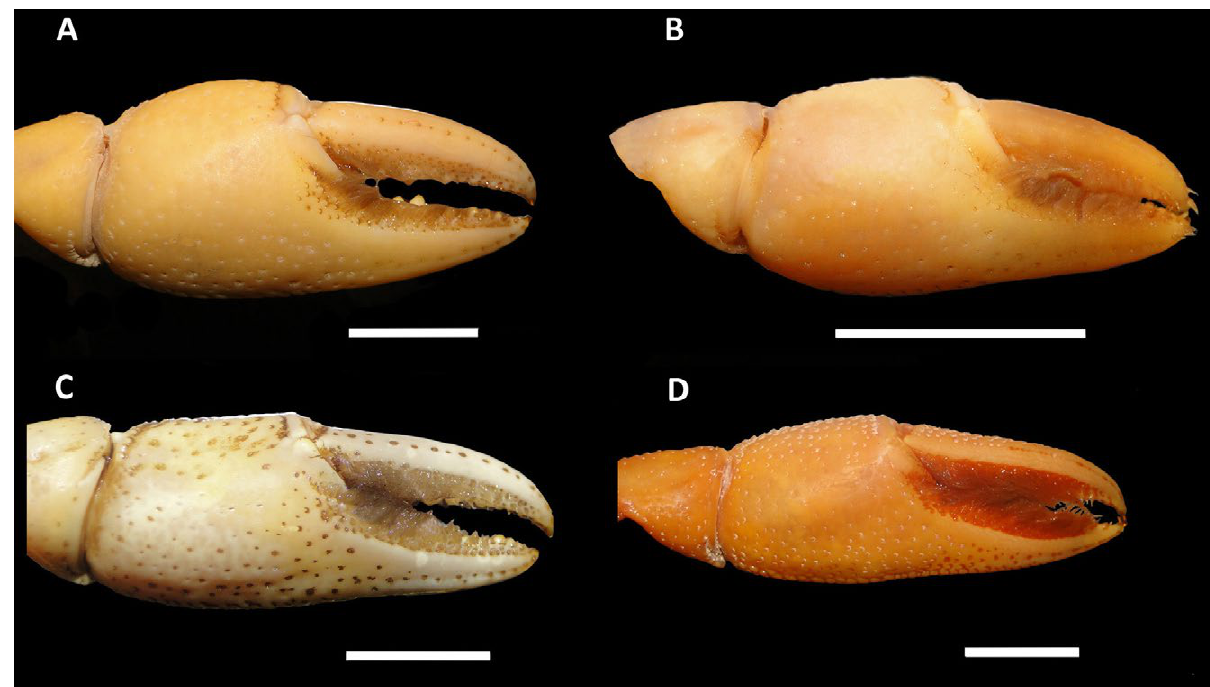
Figure 7. Comparative board of the chelipeds of selected species of genus Parastacus Huxley, 1879 with pilous cutting edge of fingers. A – P. buckupi sp. nov. (holotype); B – P. pilicarpus sp. nov. (holotype); C – P. fluviatilis Ribeiro & Buckup in Ribeiro et al. (2016) (UFRGS 2704); D – P. pilimanus (von Martens, 1869) (UFRGS 2413, CL 38.74). Scale bars: 1